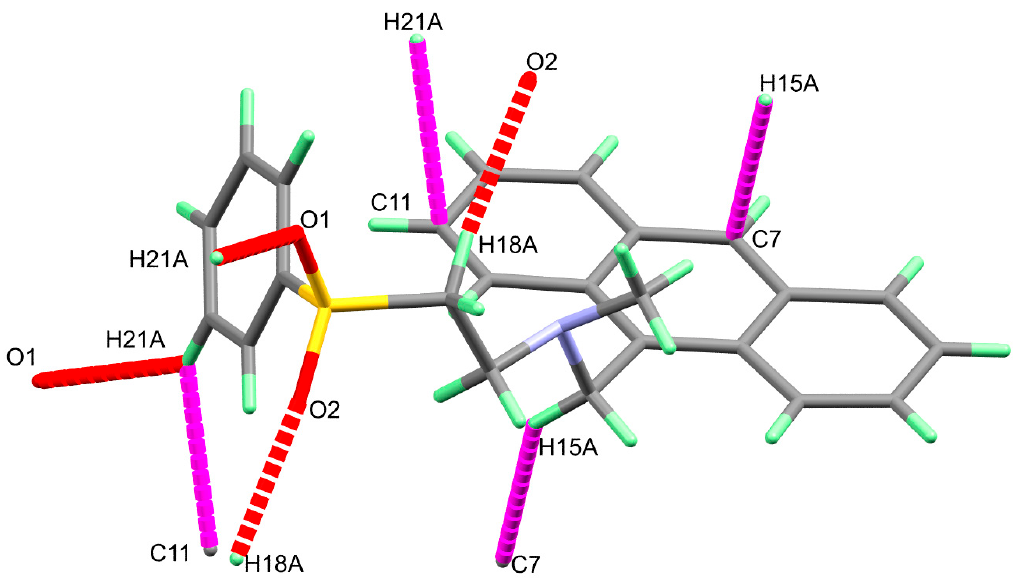
Figure 2. The intermolecular C-H... π (magenta) and O...H (red) contacts in the crystal structure of 3 . Table 3. Intermolecular contacts (Å, ◦ ) observed in the crystal structure of molecule 3